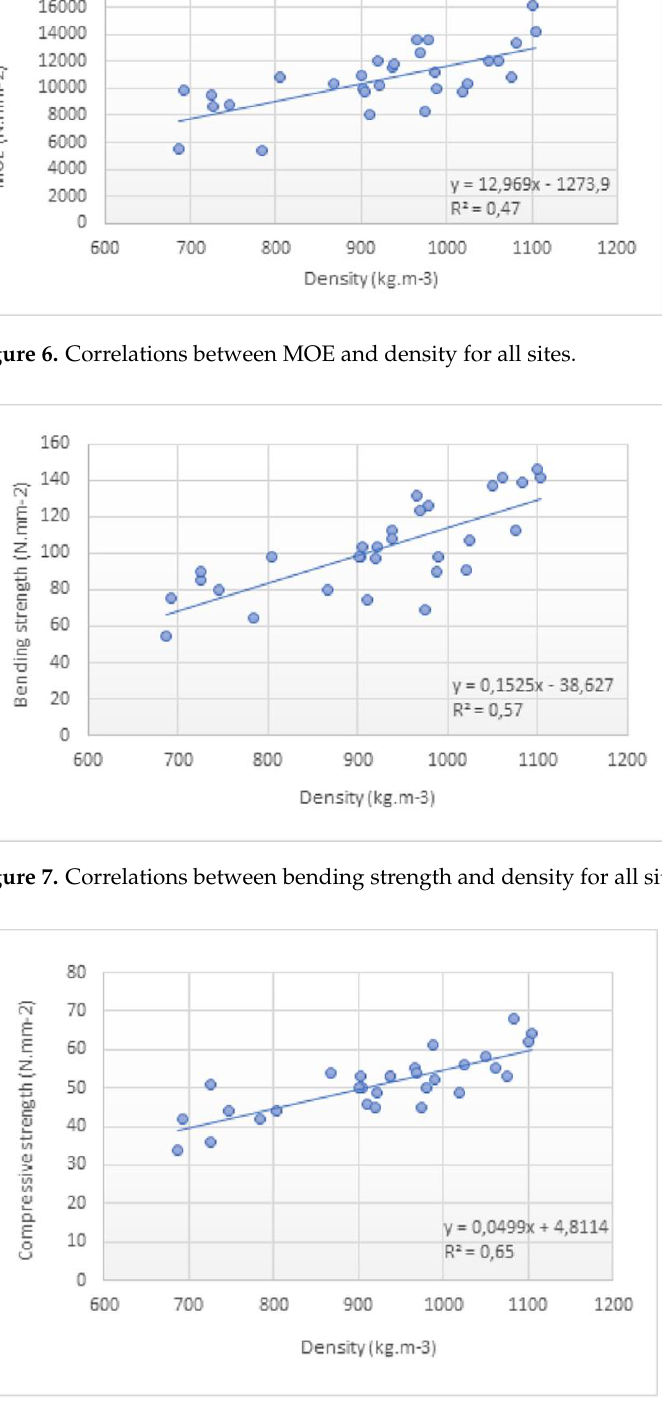
Figure 9. Correlations between bending strength and MOE for all sites. Sonderegger et al. investigated various aspects of natural aging on European oak and presented a correlation of MOE and bending strength depending on density for recent and aged oak [32]. The mechanical properties of oak wood Q. petraea were studied, namely bent at different radii for locations of the tension and compressive sides of wood using micro-mechanical test specimens [33]. This study obtained MOE values between approximately 9000 and 11,000 Nmm −2 , which indicates that the order of magnitude is close to the values obtained in the bending tests of this study. It was possible to observe that strength of wood increases as its density increases. The density is important in determining the strength properties and according to [34] correlates more with bending strength than with MOE. The values obtained are consistent with the correlation based on the literature and were verified in Figure 6 for MOE, Figure 7 for bending strength and Figure 8 for compression parallel to the grain. 4. Conclusions The results for site 1 showed a significant effect of the distance to pith, which could be related to its different soil composition as compared with site 2 and site 3. This higher density led to higher compression and bending strength as well as modulus of elasticity near the pith, with the results obtained closer to the bark similar to the ones observed for